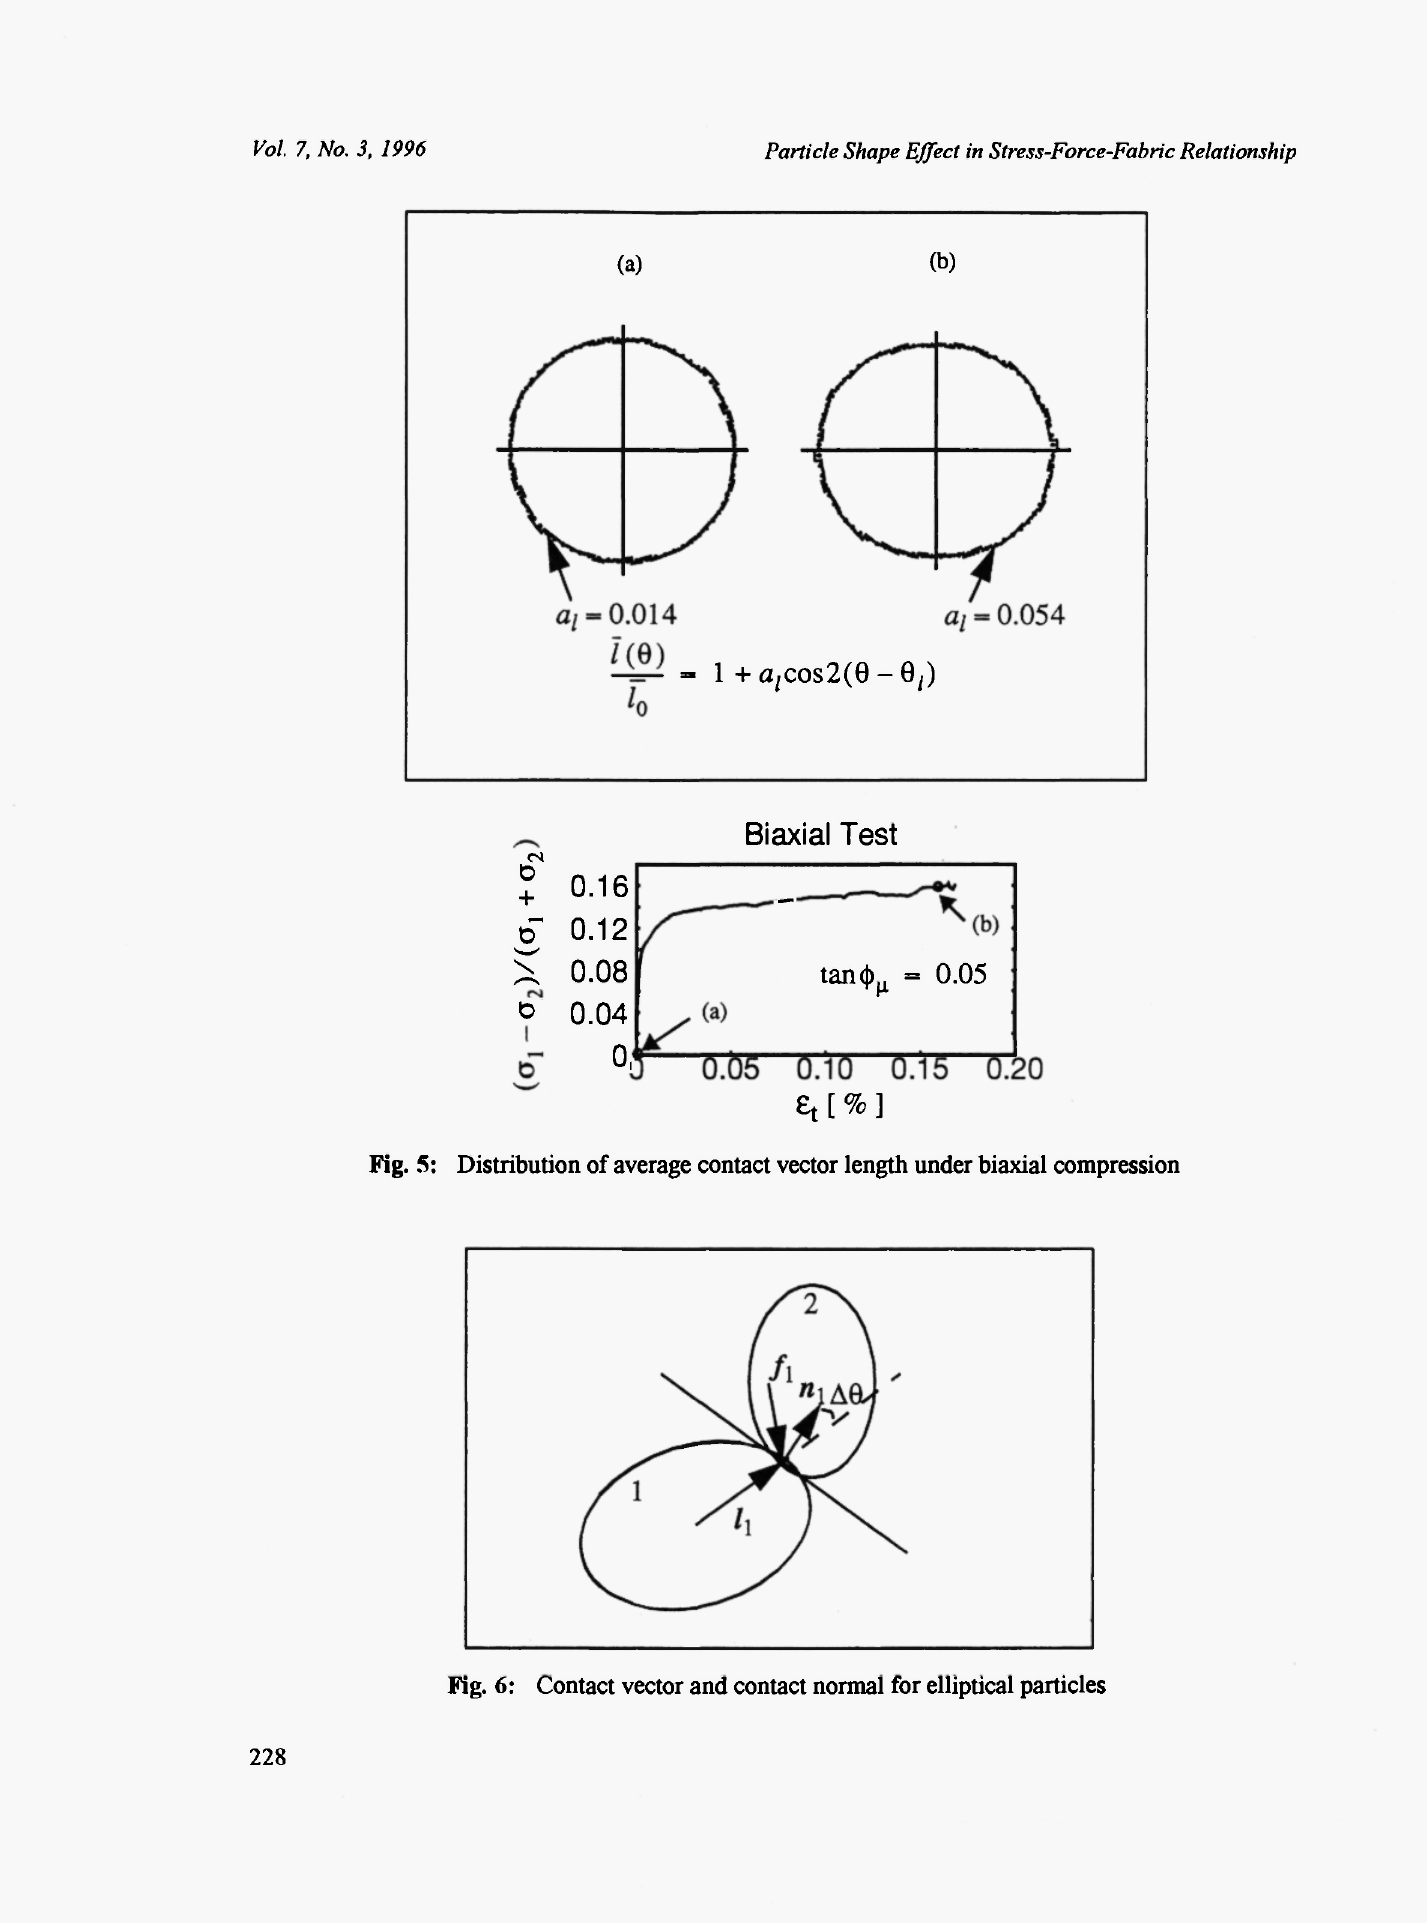
Fig. 5: Distribution of average contact vector length under biaxial compression